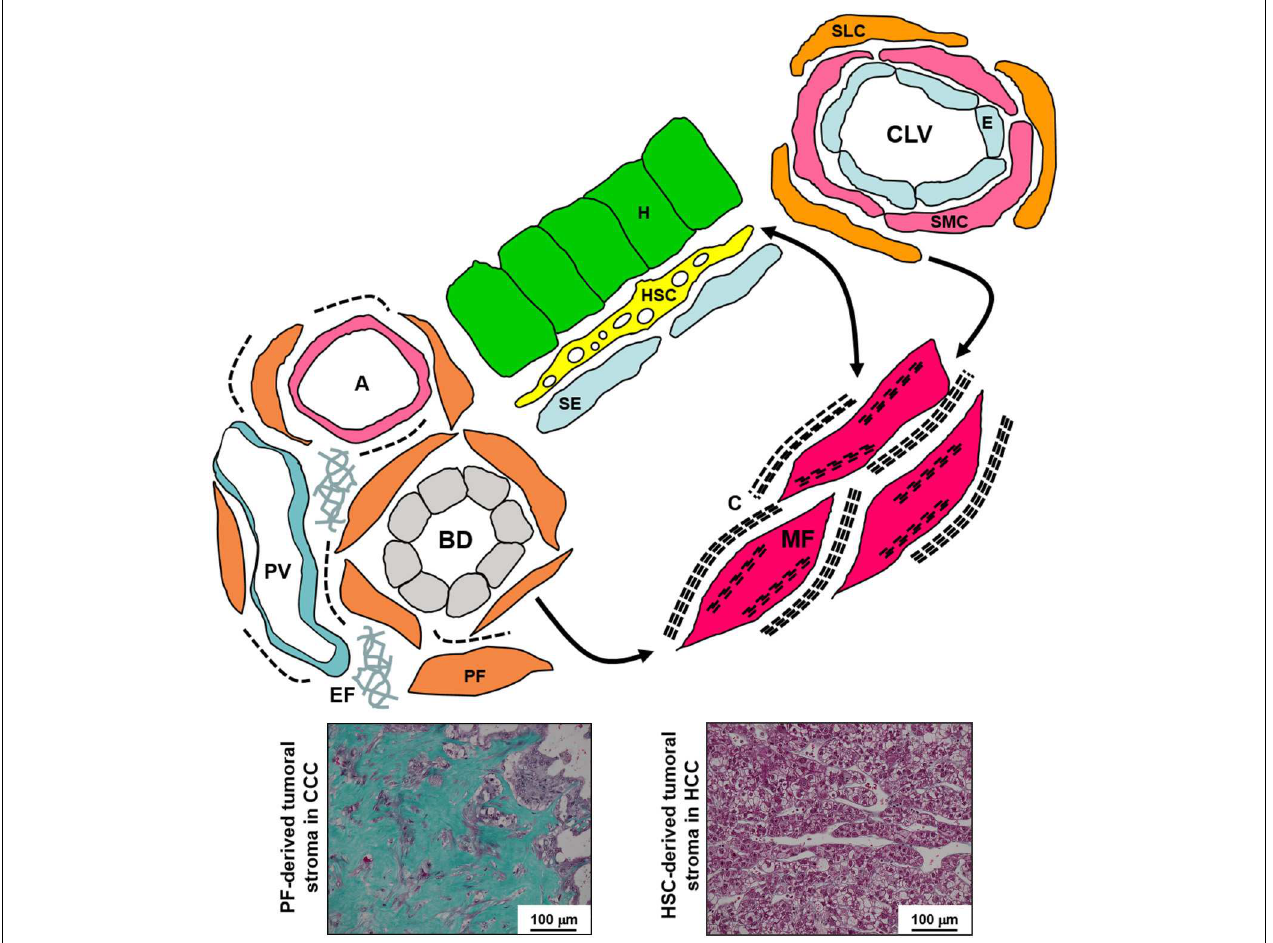
endothelium (SE) can modulate their myofibroblastic differentiation, and present pericyte-like features suggesting that they function as liver-specific pericytes participating in the regulation of sinusoidal blood pressure. Myofibroblasts (MF) present microfilament bundles and secrete large amounts of extracellular matrix. In addition, PF and PF-derived MF are the major, if not the only, cells that produce elastin. Numerous PF-derived MF are involved in the formation of the abundant fibrous stroma present in cholangiocarcinoma (CCC) while generally rare HSC-derived MF are present in the scanty tumoral stroma of hepatocellular carcinoma (HCC) (Masson’s trichrome histochemistry). C, collagen; EF, elastic